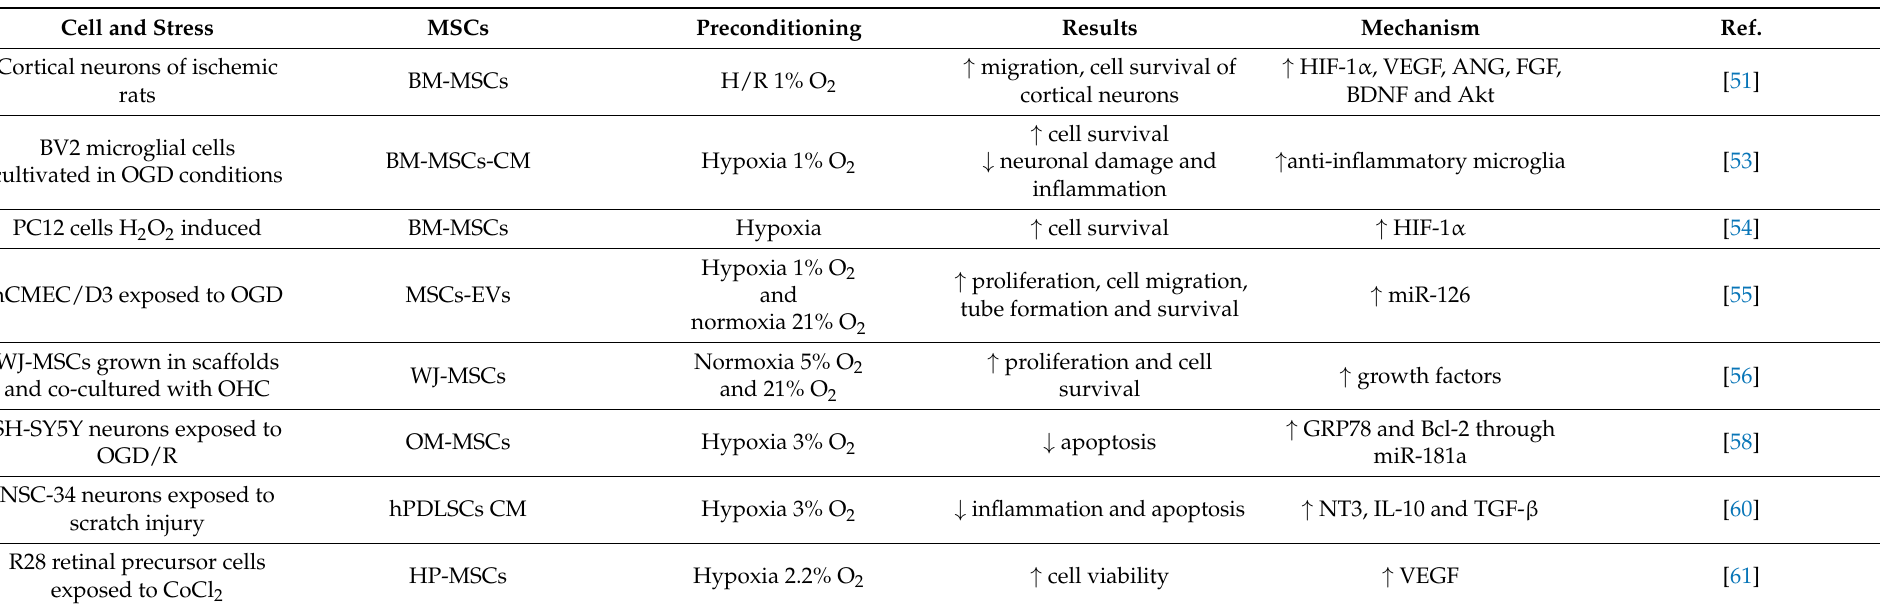
Table 2. Summary of in vitro studies that reported the effects of neuroprotection on hypoxic preconditioned